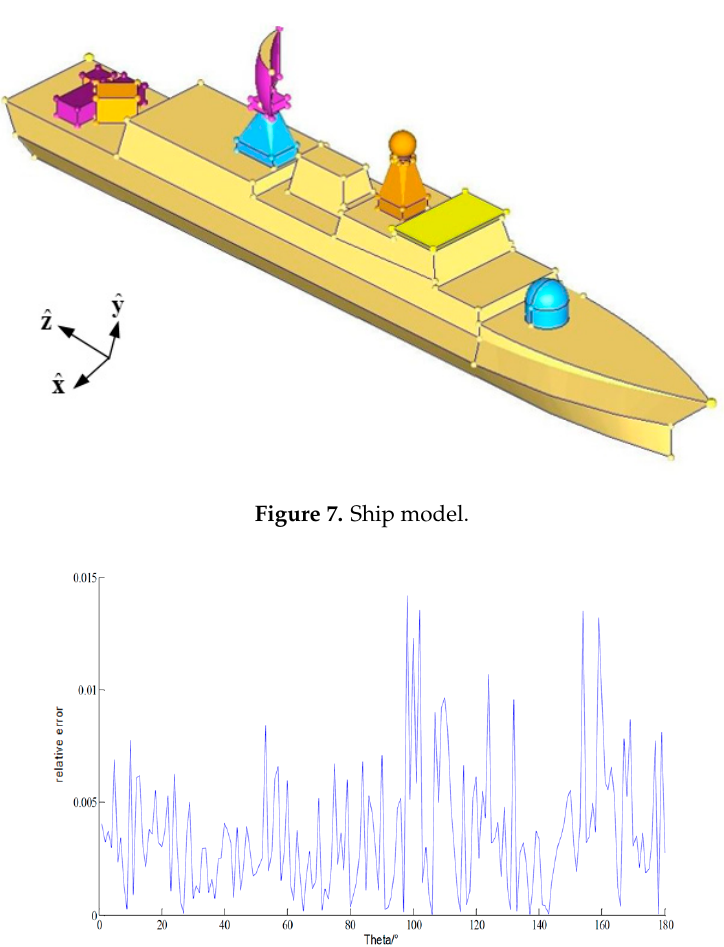
Figure 9. RCS for ship model by MLFMA and CS-MLFMA. Table 2. Computation time comparison for ship model. Algorithm